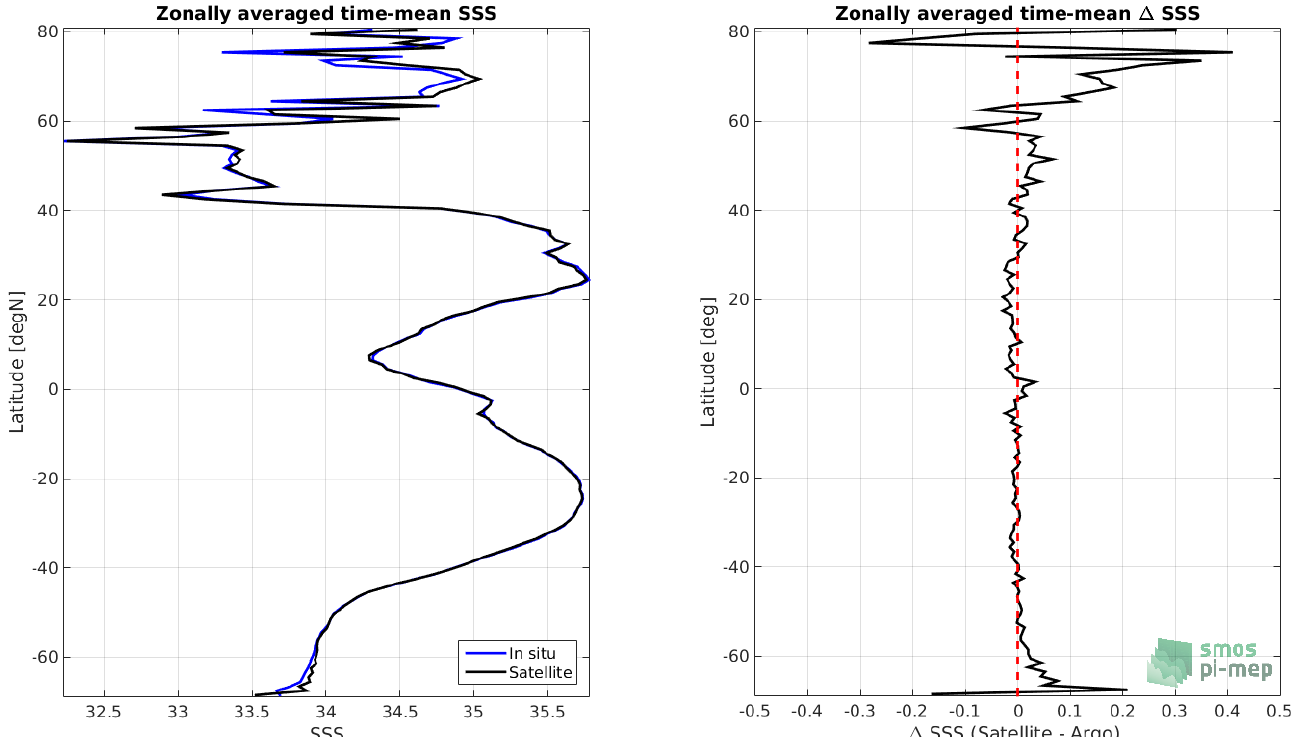
Figure 10. Left panel : Zonal mean SSS from CCI SSS L4 Merged-OI v3.2—30-day running (ESA) satellite product (black) and from Argo (blue). Right panel : Zonal mean of ∆ SSS (Satellite−Argo) for all the collected Pi-MEP match-up pairs estimated over the full satellite product